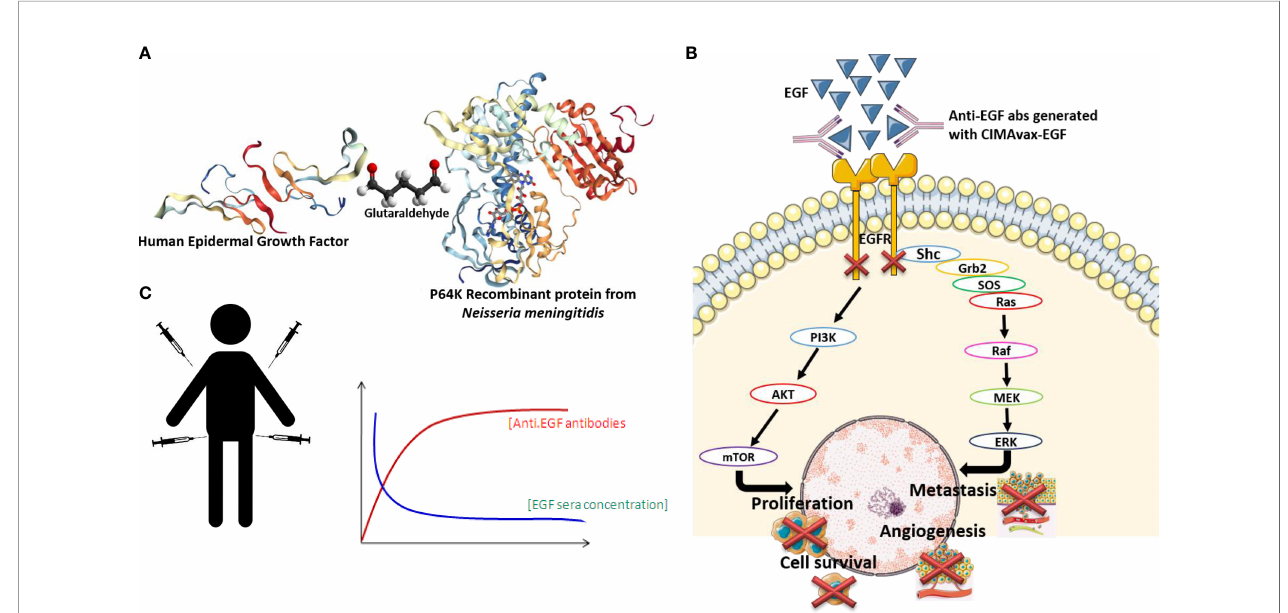
FIGURE 1 | (A) Cimavax composition: CIMAvax-EGF is a chemical conjugate between human-recombinant EGF and P64, a recombinant protein from Neisseria meningitides . (B) CIMAvax-EGF induces neutralizing antibodies that trap EGF and reduces its concentration in serum, achieving an immunological “ castration ” of the growth factor. (C) Sera of patients immunized with CIMAvax-EGF block the binding between EGF and its receptor, inhibiting the EGFR phosphorylation and cell proliferation in